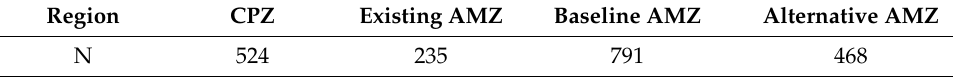
Figure 10. Map of the northern reef, CPZ, existing AMZ, and baseline AMZs using observed and modelled currents, as well as alternative AMZs using the observed and modelled currents.